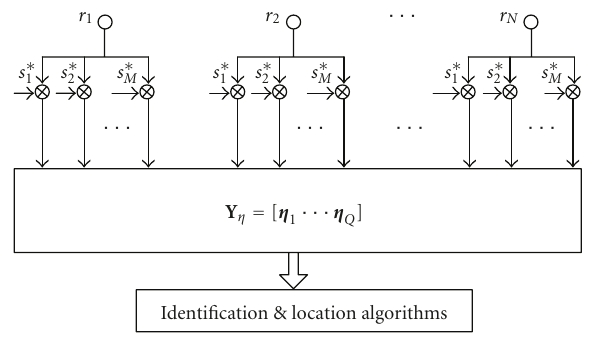
Figure 2: Su ffi cient statistic extraction and identification and local- ization